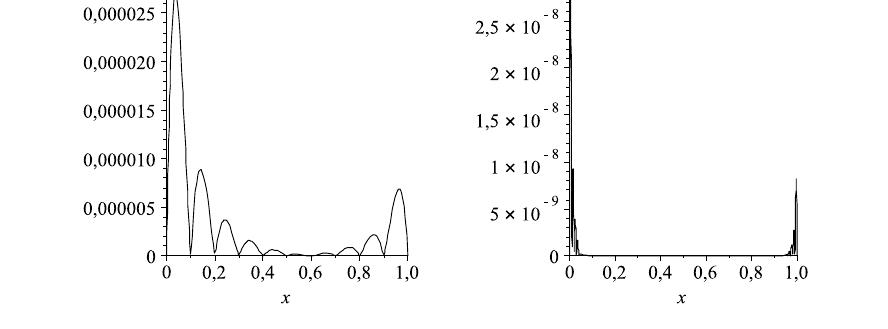
Applying S ( x ) with N = 10 and N = 100 and using Theorem 3 for the functions f 1 ( x ) and f 2 ( x ), we obtain the absolute errors. The graphs of the corresponding absolute errors are displayed in Figs. 1 and 2. We can see that by increasing the value of N the absolute errors between interpolation splines and the given functions decrease and the order of convergence of the interpolation formula (8) in these examples is O ( h 3